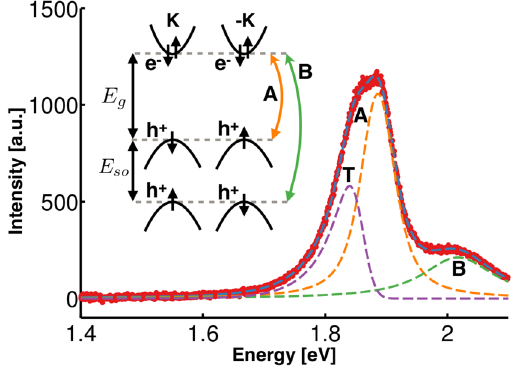
Figure 1. PL spectrum of MoS 2 at 273 K (background subtracted). Raw spectra are included in Supplementary Information S1. A and B denote excitons, and T denotes the trion. Note the trion asymmetric shape with a characteristic long low-energy tail. Inset: Band structure near the K and − K points of the Brillouin zone with band gap, E g , ~1.9 eV, and spin-orbit splitting, E so , ~140